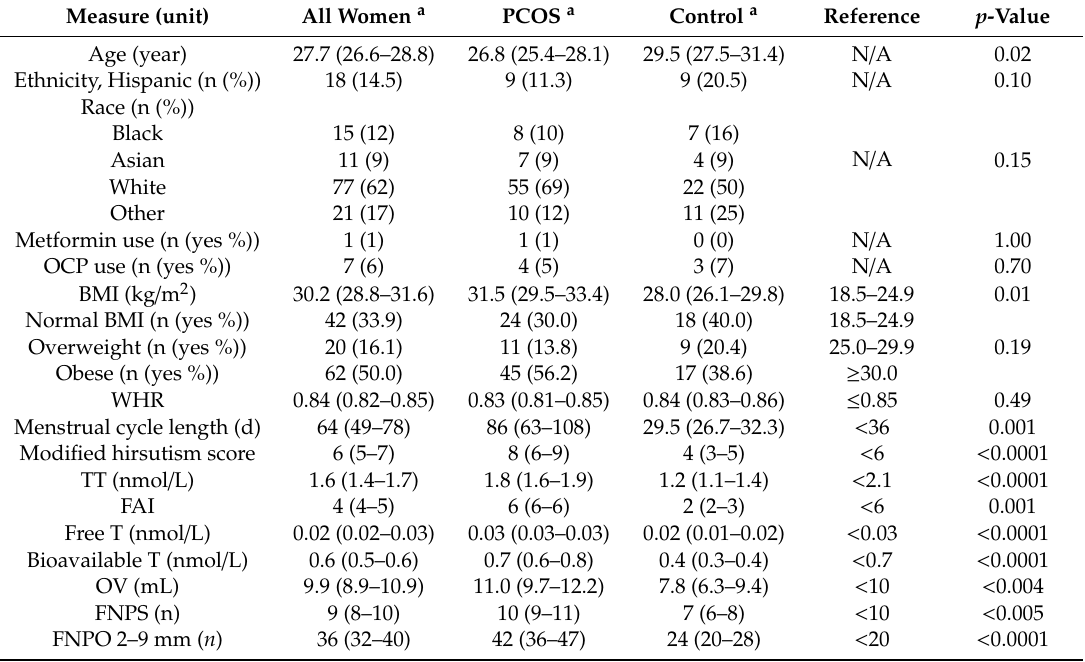
Table 1. Demographic, anthropometric, clinical, biochemical, and ultrasonographic characteristics of women with polycystic ovary syndrome and